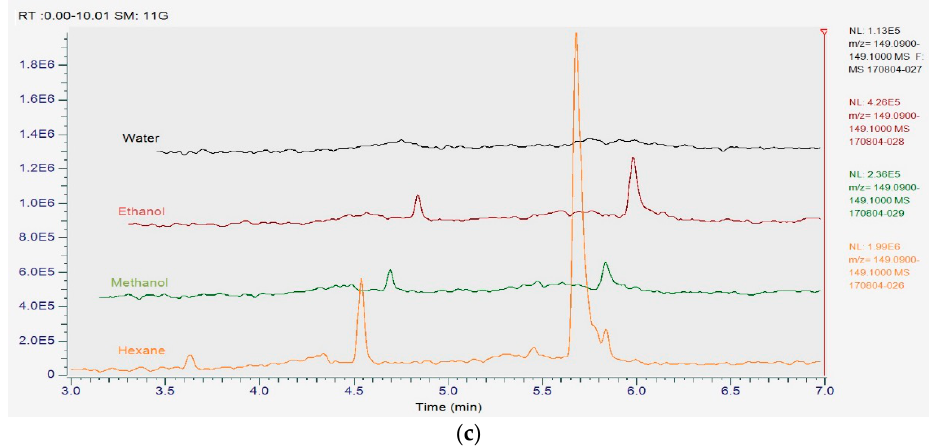
Figure 3. Chromatogram of major compounds extracted from Australian native herbs in different solvents. Citral in lemon myrtle extracts ( a ); polygodial in Tasmanian pepper leaf extracts ( b ) and anethole in anise myrtle extracts ( c ).